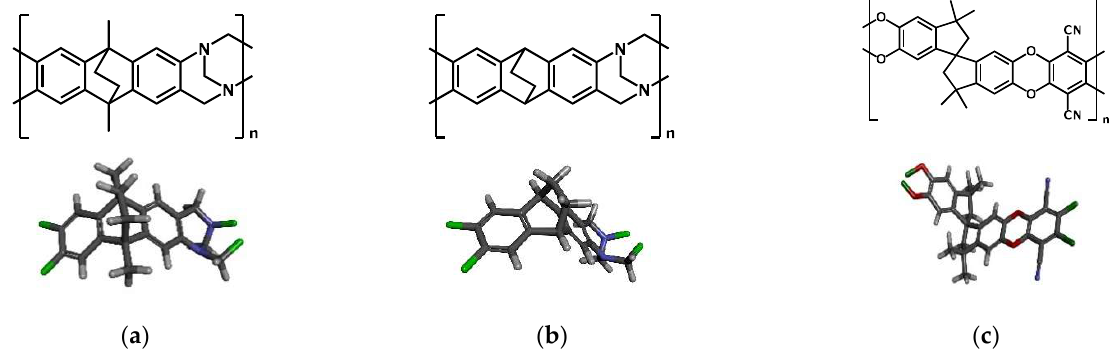
Figure 1. Chemical structure of the investigated PIMs: ( a ) PIM-EA-TB (CH3), ( b ) PIM-EA-TB (H2) and ( c ) PIM-1. Table 1. BET surface values for the discussed polymers.